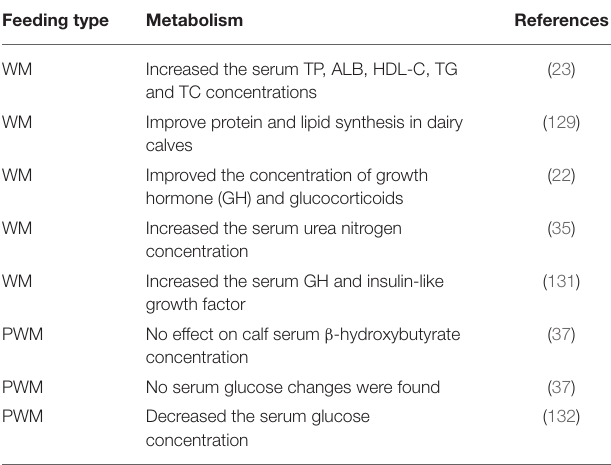
TABLE 3 | Effect of raw WM and PWM on the metabolism of calves. Feeding